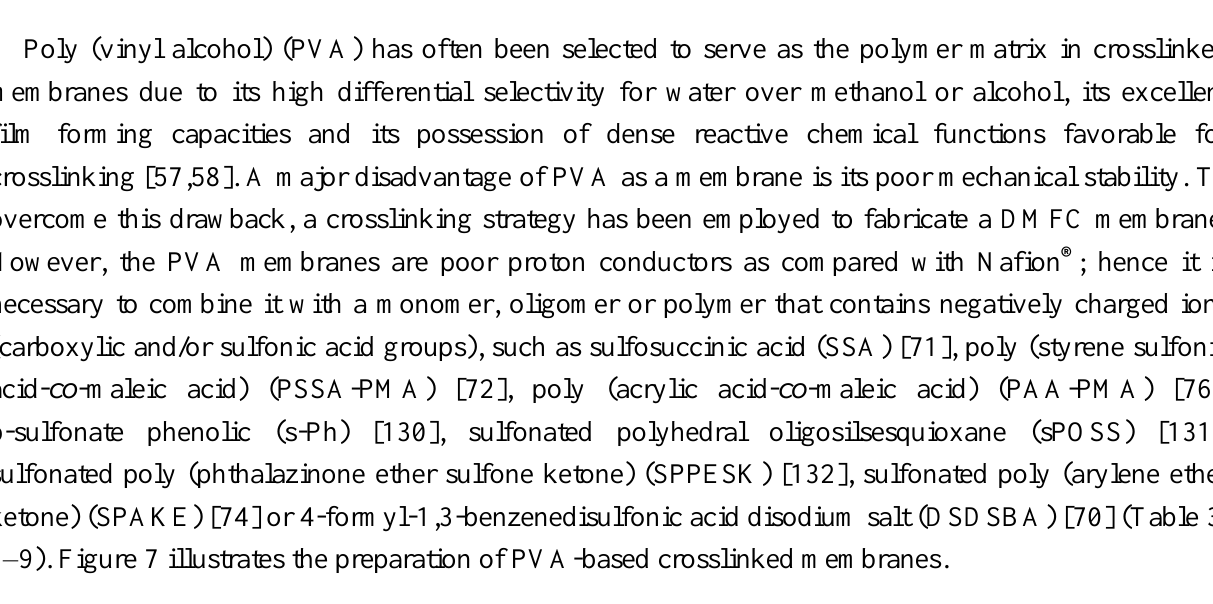
Figure 7. Scheme illustrating the preparation of PVA-based crosslinked